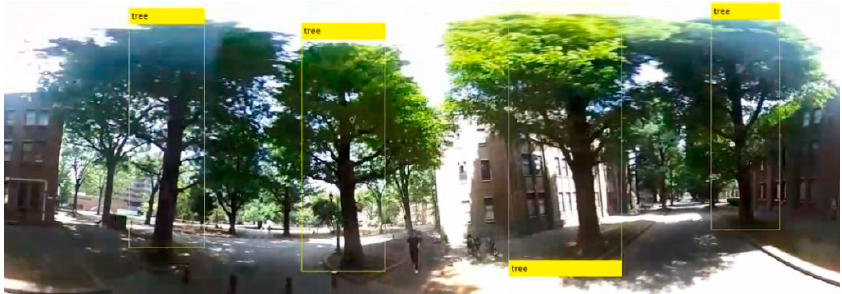
Figure 5. Example of labeling for object detection. This image was derived from video frames, and the trees in the video were labeled with bounding box manually.